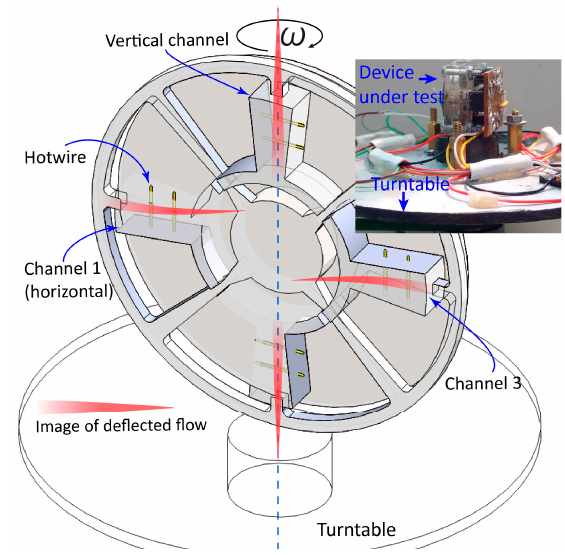
Figure 13. Schematic view of flow inside working chamber deflected under angular velocity (cid:2033)(cid:4652)(cid:4652)(cid:1318) . Flows in two horizontal channels are deflected in the opposite direction. The inset shows an experimental setup with the turntable.